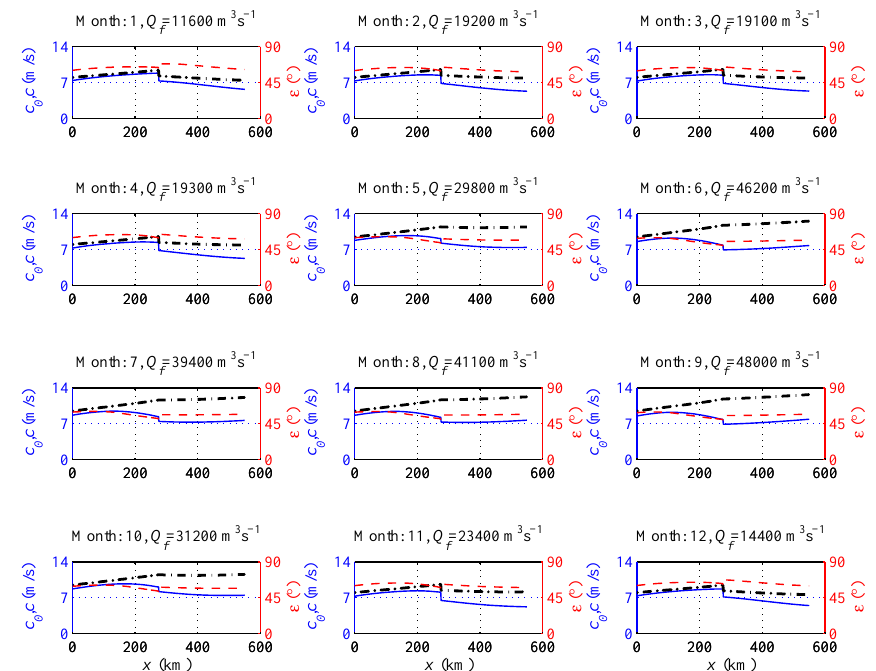
Figure 7. Longitudinal variation of the wave celerity c (blue) and the phase lag ε (red) along the Yangtze estuary in 2005. The dash-dotted line represents the classical wave celerity c 0 from Eq.